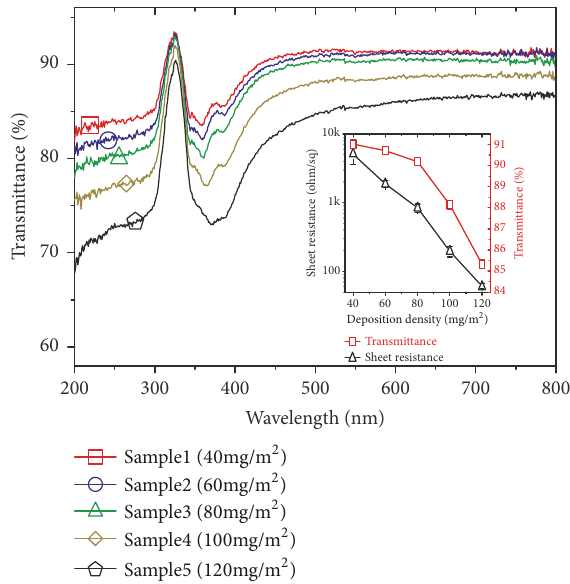
Figure 2: Optical transmittance spectra of the pure Ag NW net- works under various densities; the inset shows the sheet resistance and transmission variation of pure Ag NW